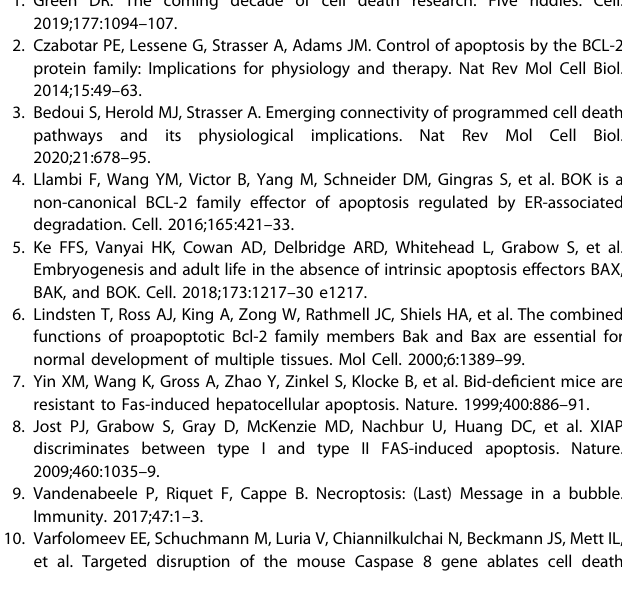
Fig. 3 E18.5 Bax − / − ;Bak − / − ;Bok − / − ;Casp8 − / − ;Mlkl − / − quintuple knockout (Q5KO) foetuses showed a range of anomalies when examined under the dissection microscope. a Percentages of 9 E18.5 Bax − / − ;Bak − / − ;Bok − / − ;Casp8 − / − ;Mlkl − / − Q5KO foetuses and 20 E18.5 Bax − / − ;Bak − / − ; Bok − / − TKO foetuses exhibiting microscopically visible developmental defects (numbers above bars represent the percentages of animals) compared by Fisher ’ s exact test. b Representative images of the large vessels of an E18.5 Bax + / + ;Bak − / − ;Bok − / − ;Casp8 − / − ;Mlkl − / − control foetus (left panel) and two Bax − / − ;Bak − / − ;Bok − / − ;Casp8 − / − ;Mlkl − / − quintuple knockout foetuses. Schematic outlines of the large vessels are shown below the images. The Bax − / − ;Bak − / − ;Bok − / − ;Casp8 − / − ;Mlkl − / − quintuple knockout foetus in the middle panel showed the absence of the right subclavian artery (arrow) and an abnormal origin of the descending aorta from the from the pulmonary trunk (*). The Bax − / − ;Bak − / − ;Bok − / − ; Casp8 − / − ;Mlkl − / − quintuple knockout foetus in the right panel displayed the absence of the right subclavian artery (arrow) and an absence of the descending aorta. Instead of leading to a descending aorta, the ascending aorta connected abnormally to the pulmonary trunk (#). AAo, ascending aorta; DA ductus arteriosus; DAo descending aorta; PT pulmonary trunk; RSA/LSA right/left subclavian artery; RCCA/LCCA right/left common carotid artery; arrows indicate site where RSA is missing; asterisk indicates DAo with abnormal origin; # indicates abnormal connection between PT and AAo. c Representative images of the ventral view of the palate of an E18.5 Bax + / − ;Bak − / − ;Bok − / − ;Casp8 − / − ;Mlkl − / − control foetus (left panel) and a Bax − / − ; Bak − / − ; Bok − / − ; Casp8 − / − ; Mlkl − / − quintuple knockout foetus with cleft of the soft and bony palate (arrows). d Image of an E18.5 Bax − / − ;Bak − / − ;Bok − / − ;Casp8 − / − ;Mlkl − / − quintuple knockout foetus with curled fi ngers (arrowhead) and protruding skin tissue in the neck region (arrow). e Image of an E18.5 Bax − / − ;Bak − / − ;Bok − / − ;Casp8 − / − ;Mlkl − / − quintuple knockout foetus with curled toes (arrowhead) and sacral spina bi fi da (arrow). f Image of an E18.5 Bax − / − ;Bak − / − ;Bok − / − ;Casp8 − / − ;Mlkl − / − quintuple knockout foetus with curled toes (arrowhead) and curled tail (T). g Image of an E18.5 Bax − / − ;Bak − / − ;Bok − / − ;Casp8 − / − ;Mlkl − / − quintuple knockout foetus with excess toe tissue